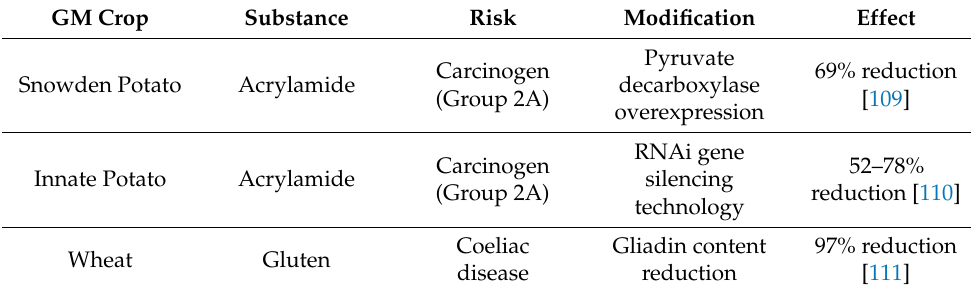
Table 4. Healthier crops obtained through